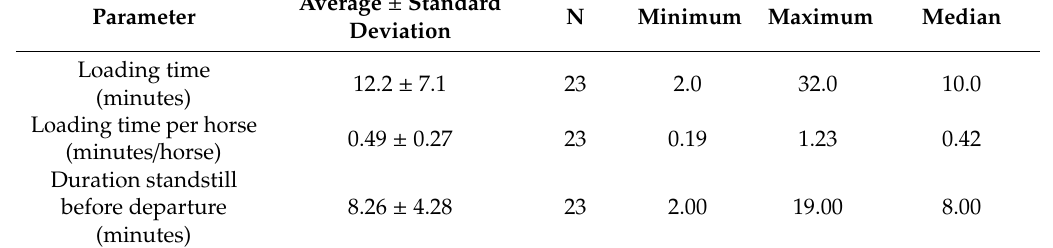
Table 2. Duration of loading and standstill after loading before departure.